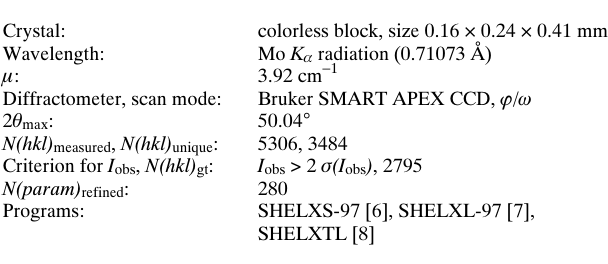
Table 1. Datacollection and